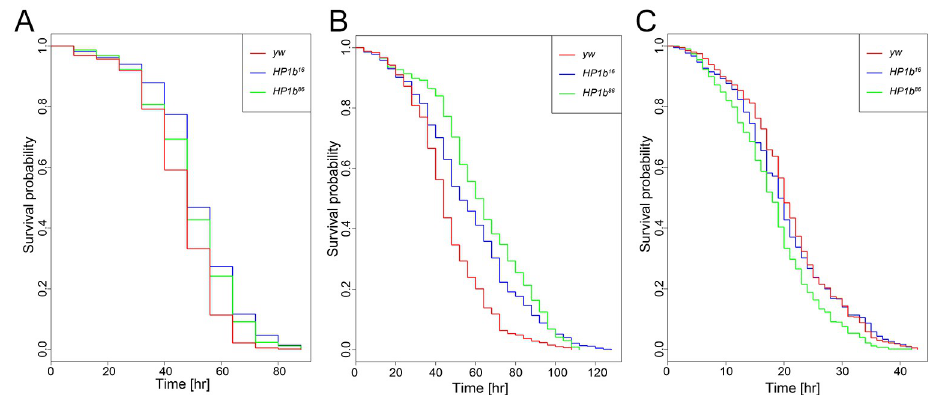
Fig 5. Loss of HP1B increases survival during starvation and oxidative stress, but not during heat stress. A . HP1b mutant animals survive significantly longer during starvation condition than yw control animals (p = 1.022e-13 and p = 7.188e-06 for HP1b 16 and HP1b 86 , respectively, Kruskal-Wallis rank sum test). B . HP1b mutant animals survive significantly longer after exposure to the oxidizer paraquat than yw control animals (p = 3.057e-13 and p < 2.2e-16, for HP1b 16 and HP1b 86 , respectively, Kruskal-Wallis rank sum test). C . HP1b mutant animals do not show improved survival during heat stress conditions (37˚C) compared to yw control animals. In contrast, they show lower